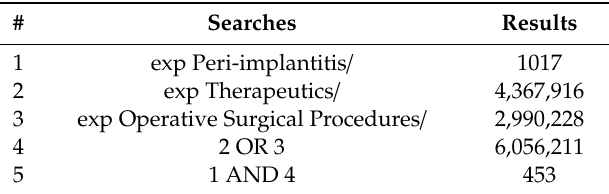
Table 3. Search Strategy for Medline via